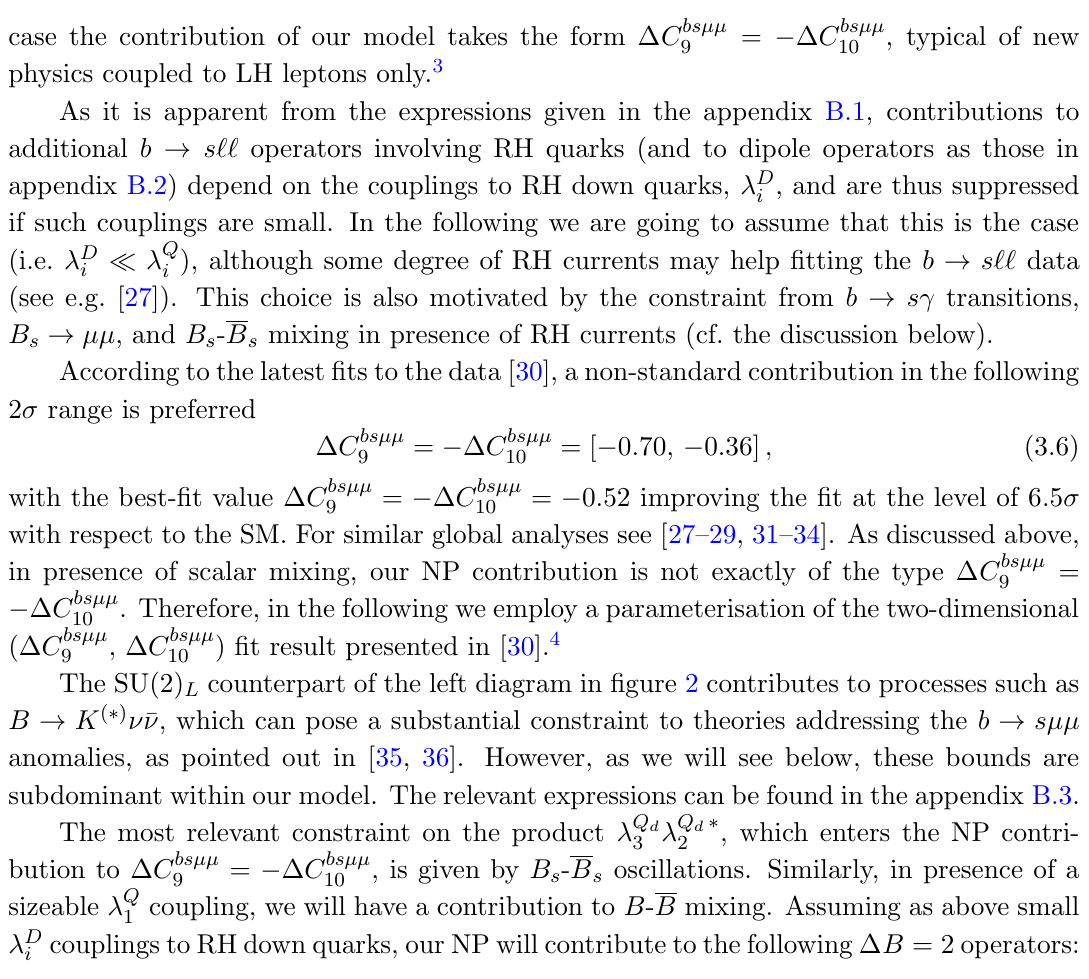
and C bs(cid:22)(cid:22) 9 10